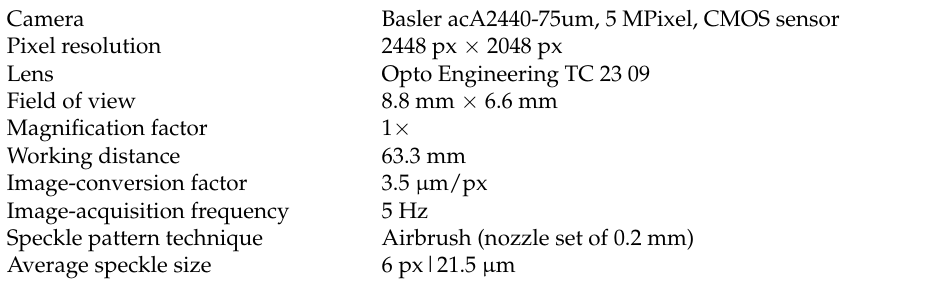
Table 3. Camera-lens optical system for the miniaturized